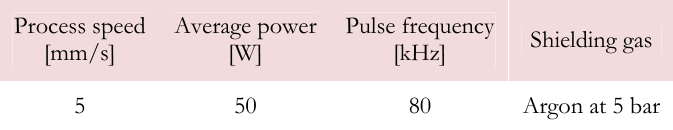
Table 5: Main process parameters used in laser micro-cutting of the elliptical